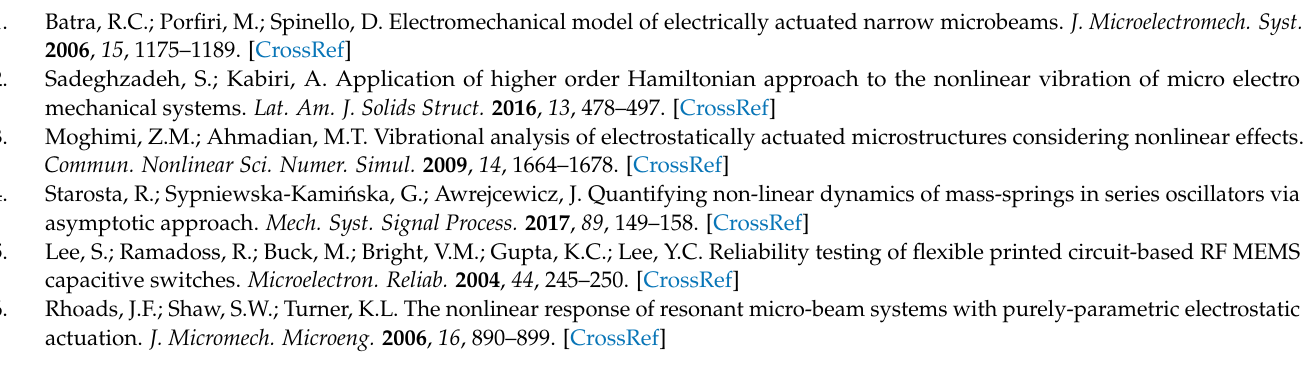
a on nonlinear frequency of electrostatically actuated microbeam. Figure 5. Effect of parameter α on nonlinear frequency of electrostatically actuated Figure 5. Effect of parameter